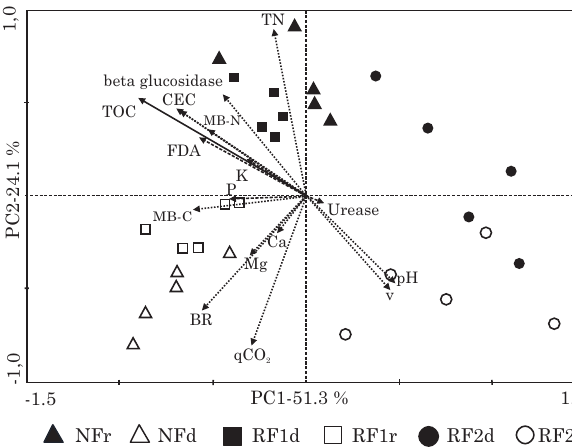
Figure 4. Principal component analysis (PCA) ordination diagram of the PECJ forests, NFr (natural forest, rainy season), NFd (natural forest, dry season), RF1r (replanted forest 1, rainy season), RF1d (replanted forest 1, dry season), RF2r (replanted forest 2, rainy season), and RF2d (replanted forest 2, dry season), as well as soil chemical and biochemical